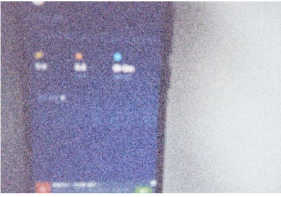
Figure 7. Pedometer.